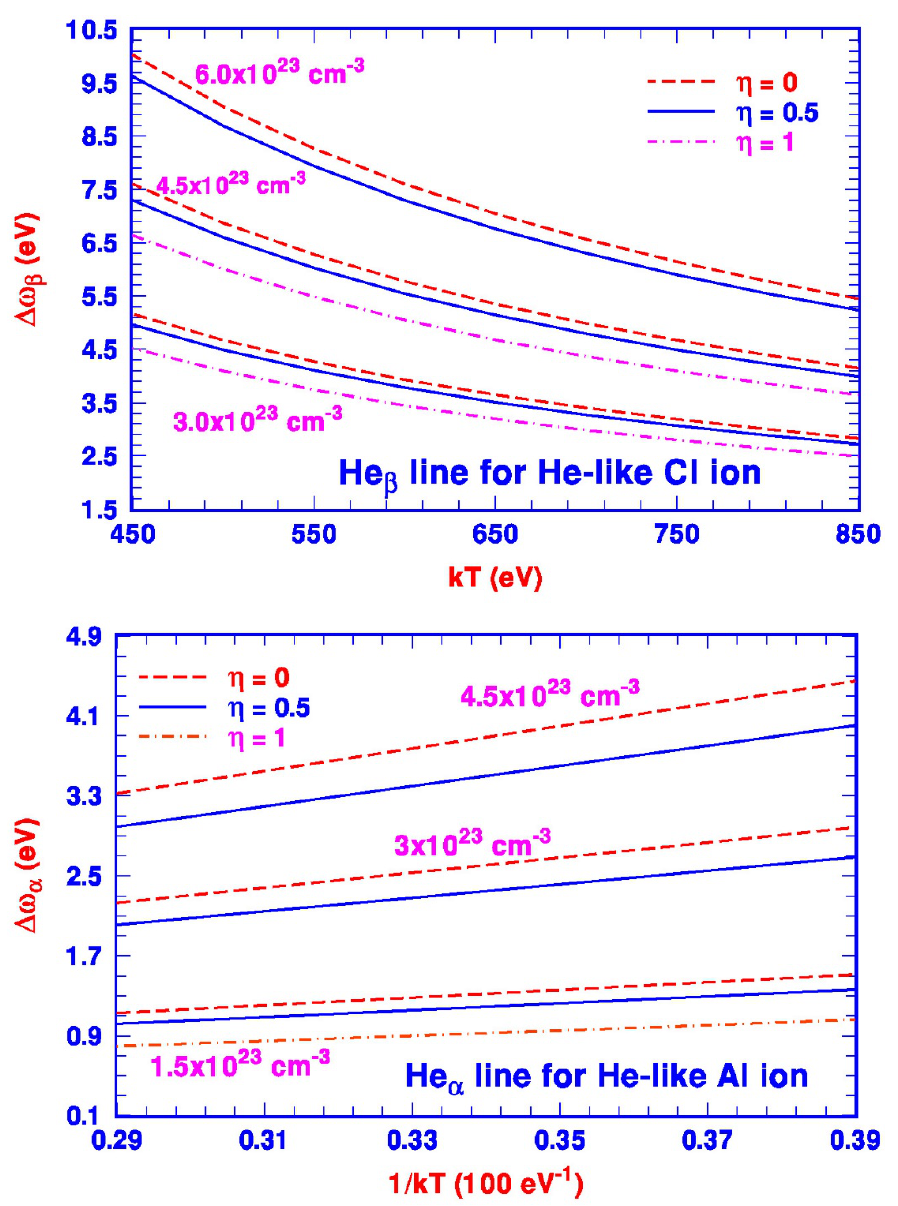
Figure 4. The theoretically estimated redshifts ∆ ω as functions of kT and 1/ kT derived from Equation (17) at a number of plasma